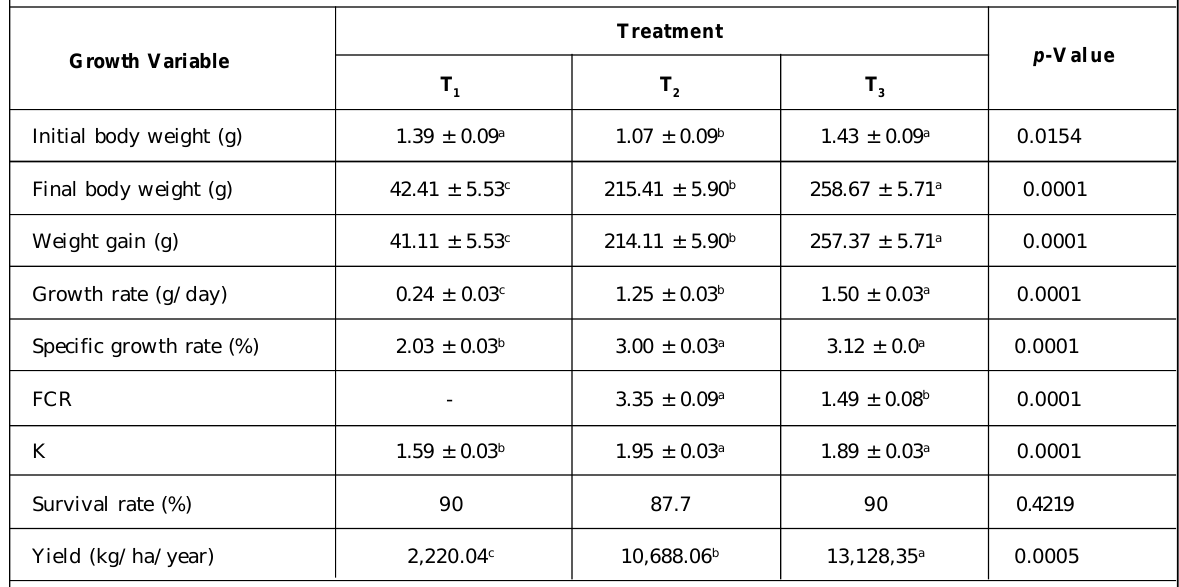
Table 2: Comparison of growth performance, FCR, condition factor, survival and yield of Nile tilapia ( O. niloticus ) cultured in concrete tanks under three different